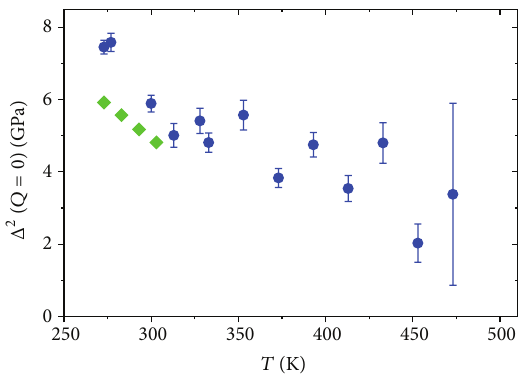
Figure 17: The temperature dependence of the 𝑄 = 0 extrapolated relaxationstrengthderivedfrom[13](solidcircles)iscomparedwith the corresponding variable determined by US measurements [37].